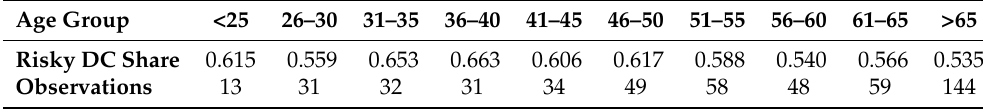
Table 1. Distribution of Risky Shares of DC Plans Across Ten Age Groups for Women in the 2019 SCF.